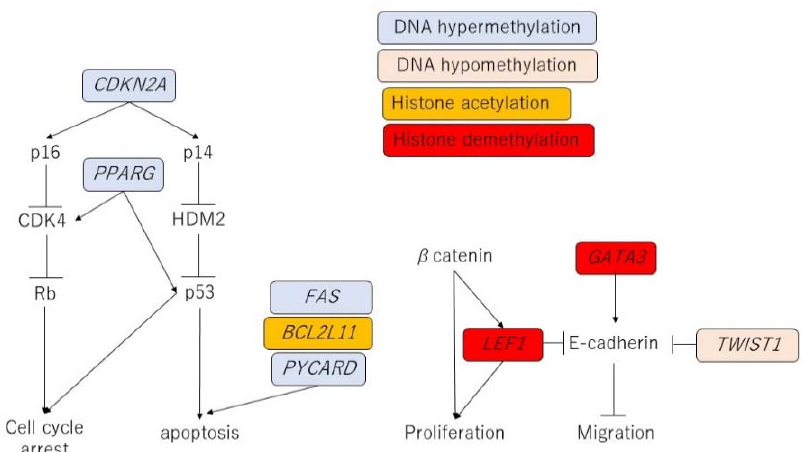
Figure 1. Signal transduction and epigenetic modification network in CTCL. DNA hyper- and hypomethylation and histone acetylation and deacetylation influence the expression of targeted genes and development of tumor via signal transduction. CDKN2A : Cyclin Dependent Kinase